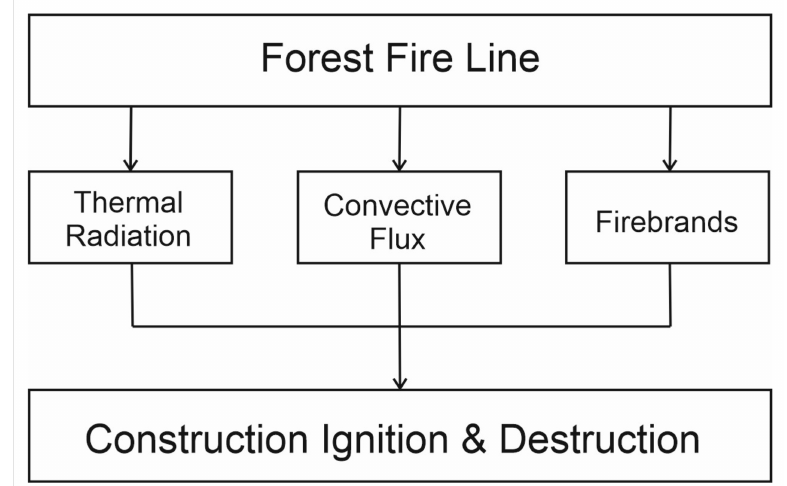
Figure 2. Fire Impact